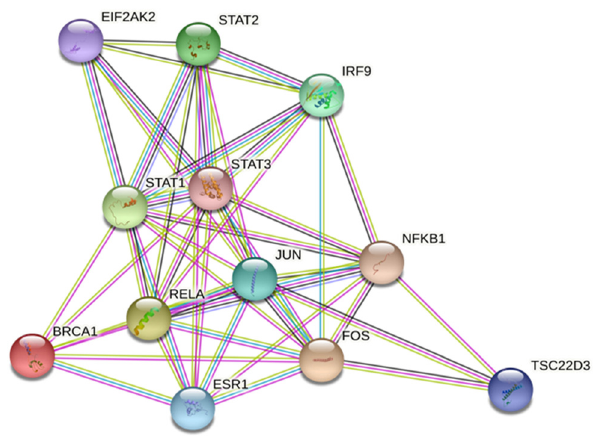
Figure 11: A summary of critical hubs, a module ( STAT1, STAT3, RELA, and JUN ) and critical nodes ( BRCA1, TSC22D3, ESR1, and EIF2AK2 ) involved in innate and adaptive